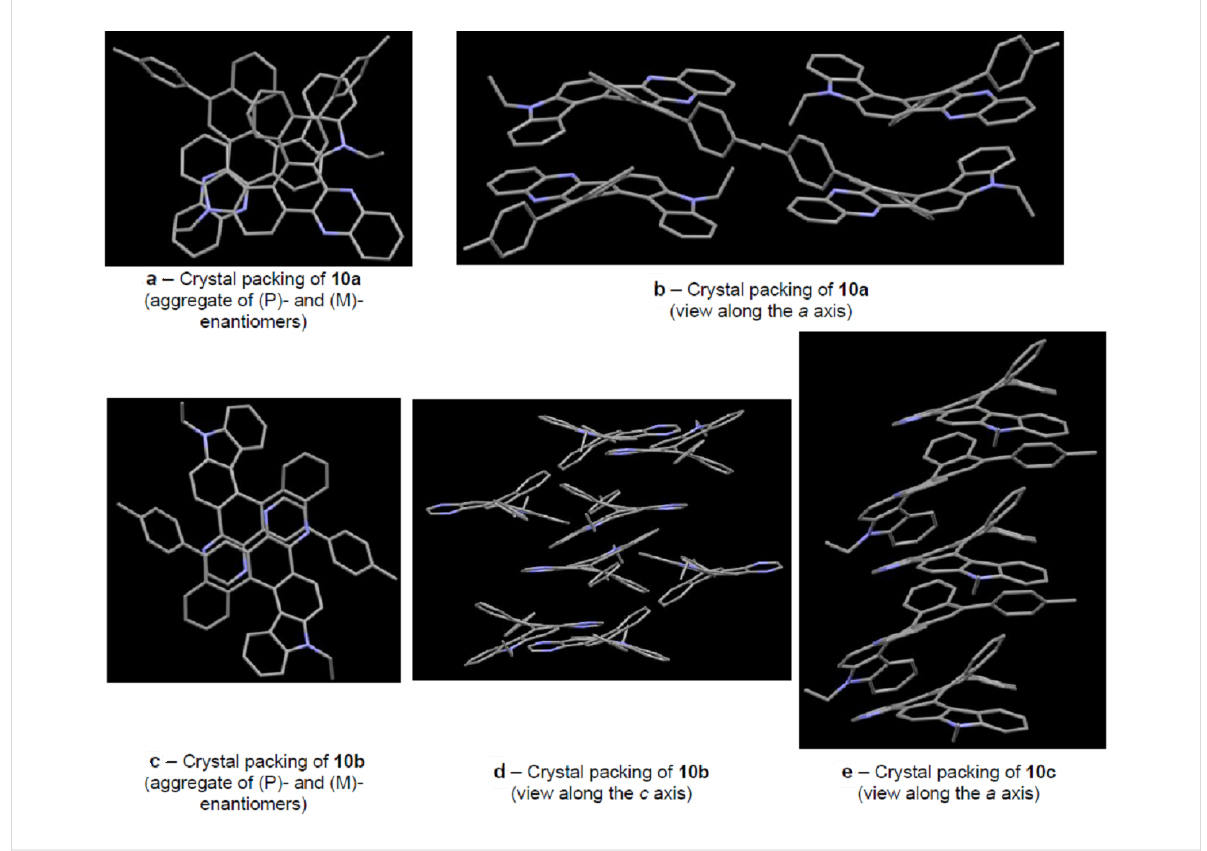
Figure 2: Crystal packing of carbazole-based [6]helicenes 10a (a, b), 10b (c,d) and 10c (e). Hydrogen atoms are hidden.